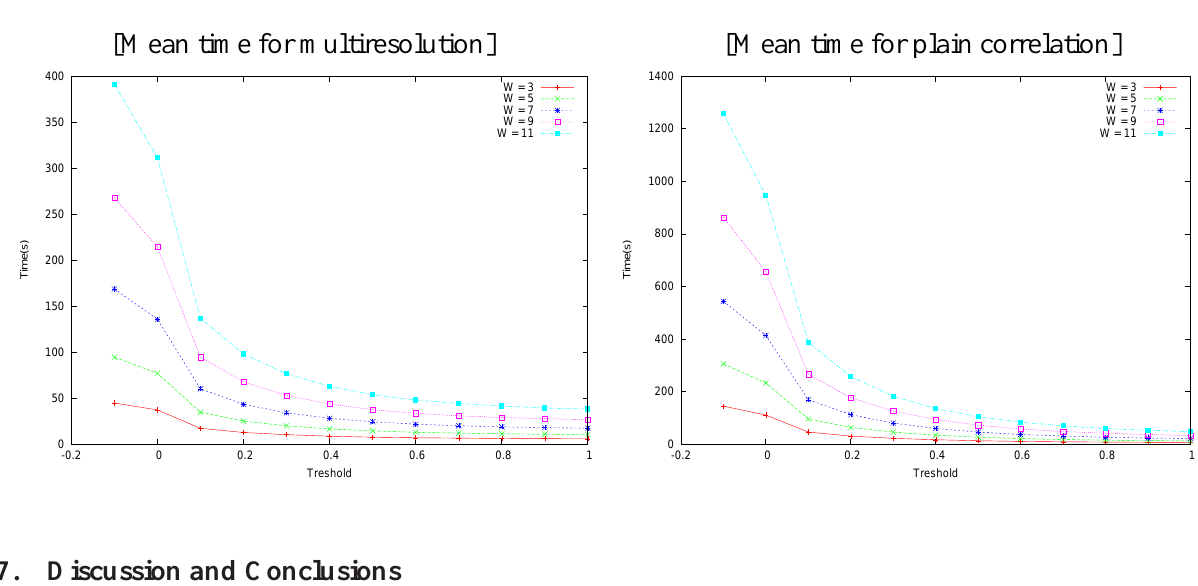
Figure 19. Required